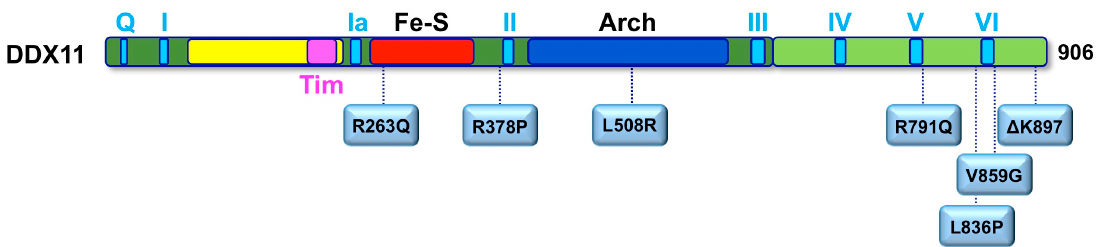
Figure 4. Missense mutations found in Warsaw breakage syndrome (WABS) patients. Schematic representation on the human DDX11 polypeptide chain (colour-coded as in Figure 3A), showing the location of the amino-acid substitutions described in individuals affected by WABS. See text for details.